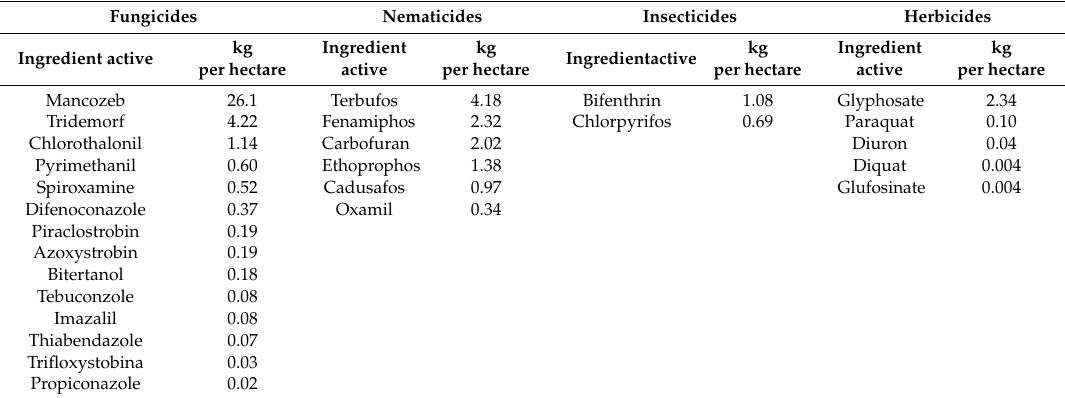
Table 1. Quantities applied (kg / Ha) of banana pesticides by biocidal action, active ingredient and total (Atlantic Zone, Costa Rica). Fungicides Nematicides Insecticides